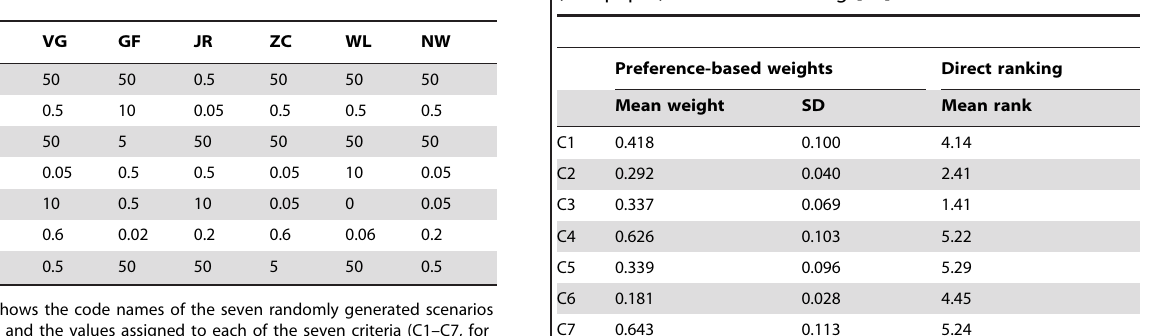
Table 4. Comparison between preference-based weights (this paper) and direct ranking